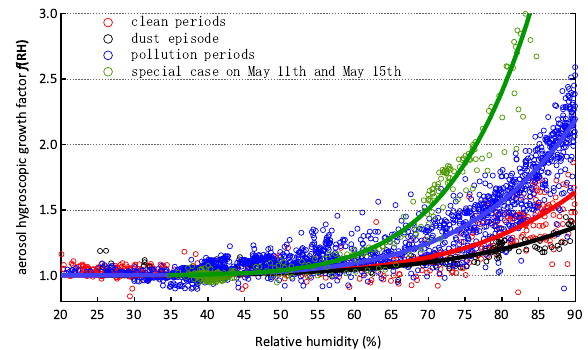
Fig. 5. Fitting curves of different dominant aerosol types. Among them, dot data represent the measurement results and lines stand for the fitting output of Eq. (2) for different aerosol types. Black, red, blue and green refer to the results of dust, clean, urban pollution and special case for urban pollution episodes,